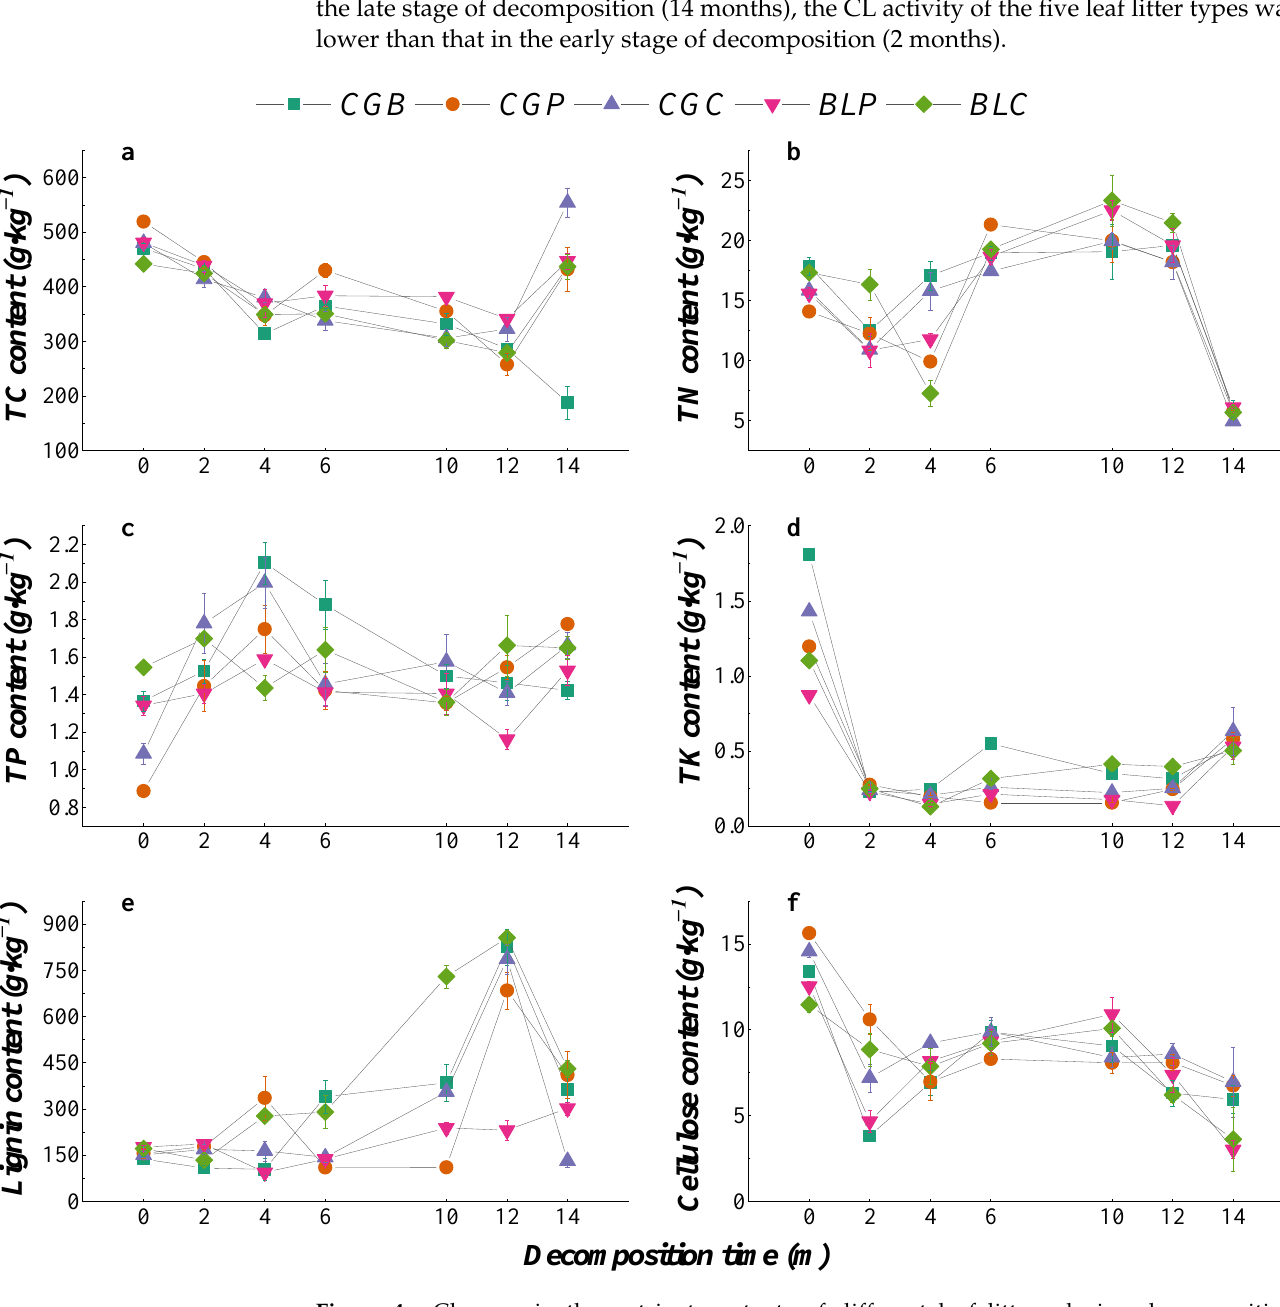
Figure 4. Changes in the nutrient contents of different leaf litters during decomposition. ( a – f ) represents the TC content, TN content, TP content, TK content, Lignin content and Cellulose content.